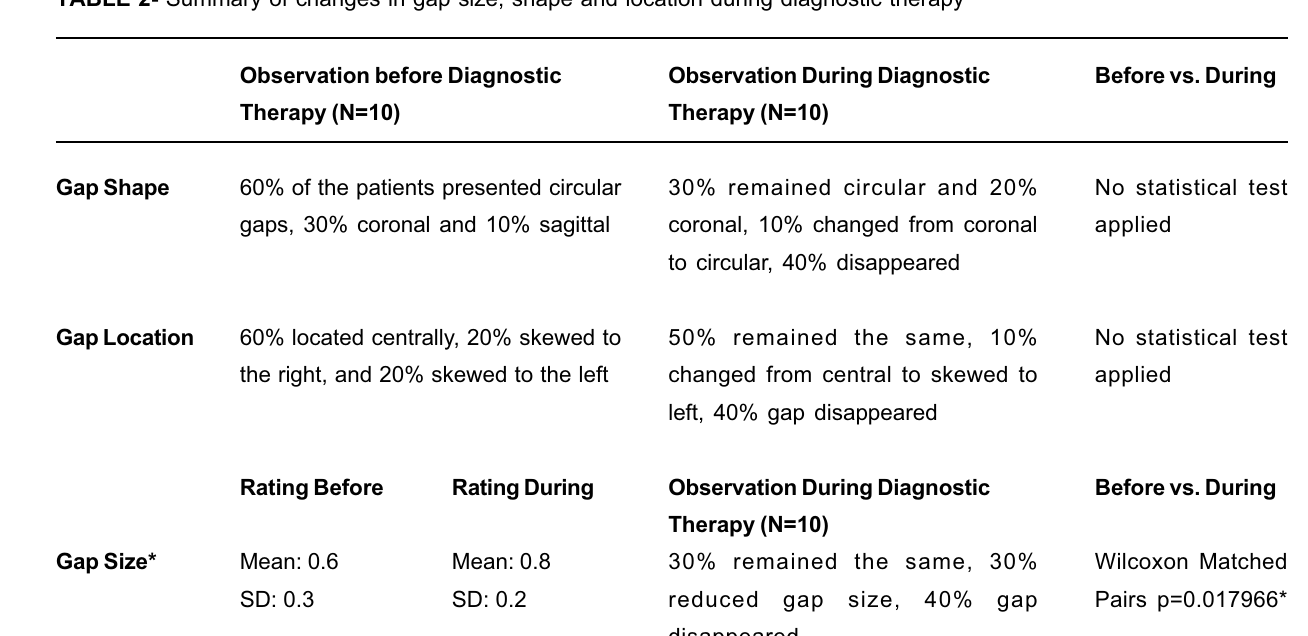
TABLE 2- Summary of changes in gap size, shape and location during diagnostic therapy